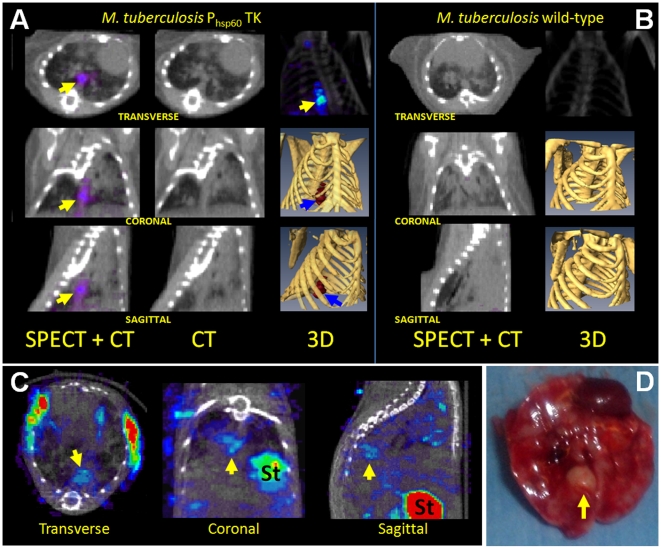

Mycobacterium tuberculosis Phsp60 TK signal localizes to caseating granulomas in lungs of C3HeB/FeJ mice.A. [125I]FIAU-SPECT/CT images from M. tuberculosis Phsp60TK infected C3Heb/FeJ mice 6-weeks after a low-dose aerosol infection. 3-D co-registered SPECT (blue/red) and CT (yellow) images are also shown. SPECT signal co-localizes to TB granulomas in the lungs of M. tuberculosis Phsp60TK infected mouse (arrows). B. Though extensive lung disease is present, images from M. tuberculosis wild-type infected mouse show no SPECT activity in the lungs. C. M. tuberculosis Phsp60TK SPECT signal localizes to a TB granuloma (arrows) in C3Heb/FeJ mice imaged 8-weeks after infection. D. The same lung and TB granuloma (arrow) is shown post-mortem. Ex-vivo radioactivity in the selected granuloma was 5318 counts per minute per milligram of tissue compared with 2364 in lung tissue outside of the granuloma and 856 in lung tissue from the animal infected with M. tuberculosis wild-type strain (St = Stomach).